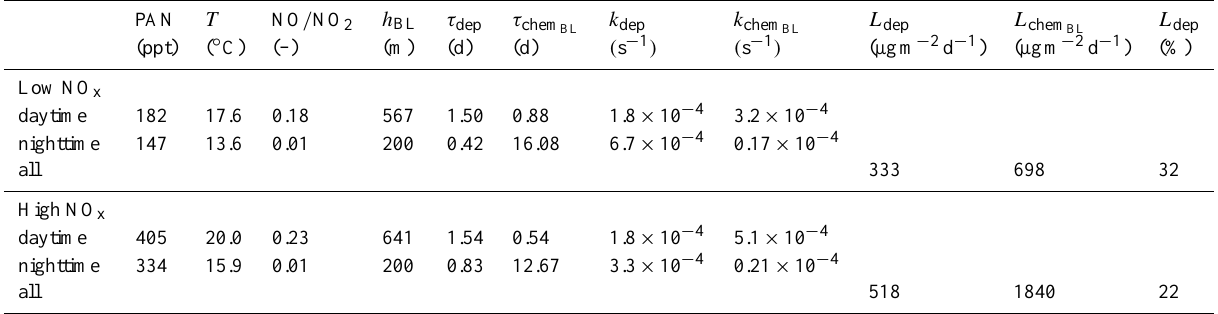
Table 2. Modelled PAN deposition and thermochemical loss for low and high NO x conditions at the Mainz Finthen grassland site. The description of the shown parameters is given in the